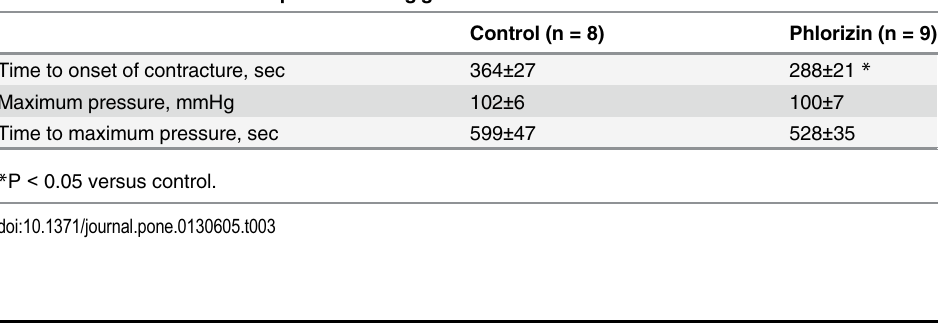
Table 3. Ischemic contracture profiles during